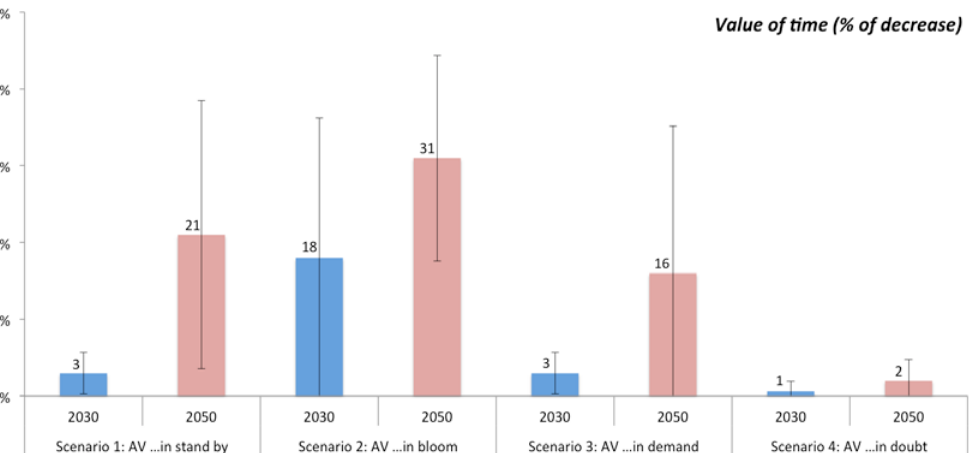
Figure 4. Estimation of decrease in value of time of automated vehicle users in different scenarios. Each bar represents average value of five experts responses collected in Delft University of Technology workshops and error bar depicts standard